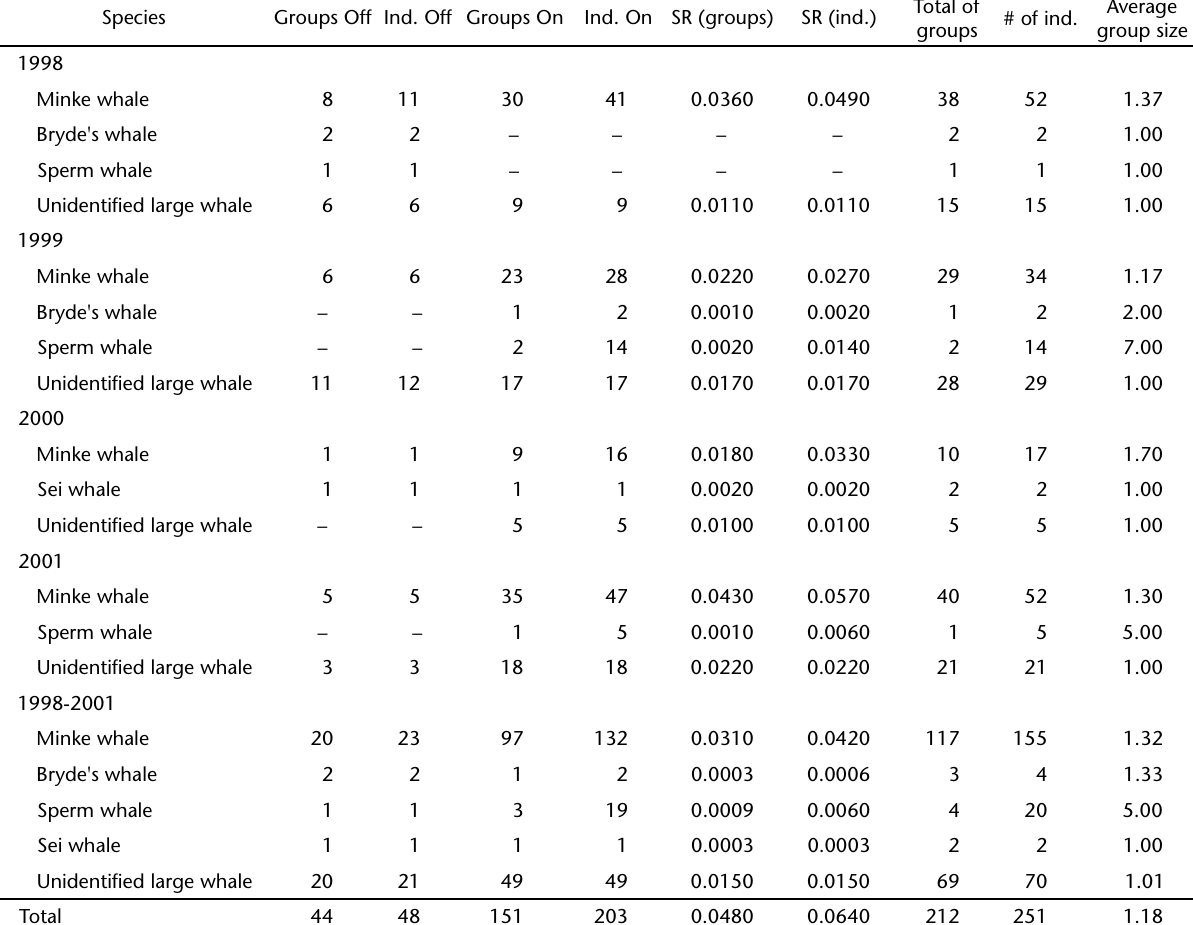
Table IV. Large whales sightings, sighting rates (SR groups or individuals/nm) and average group sizes observed during the cruises conducted off northeastern Brazil (Off Effort – Off; On Effort – On). Species Groups Off Ind. Off Groups On Ind. On SR (groups) SR